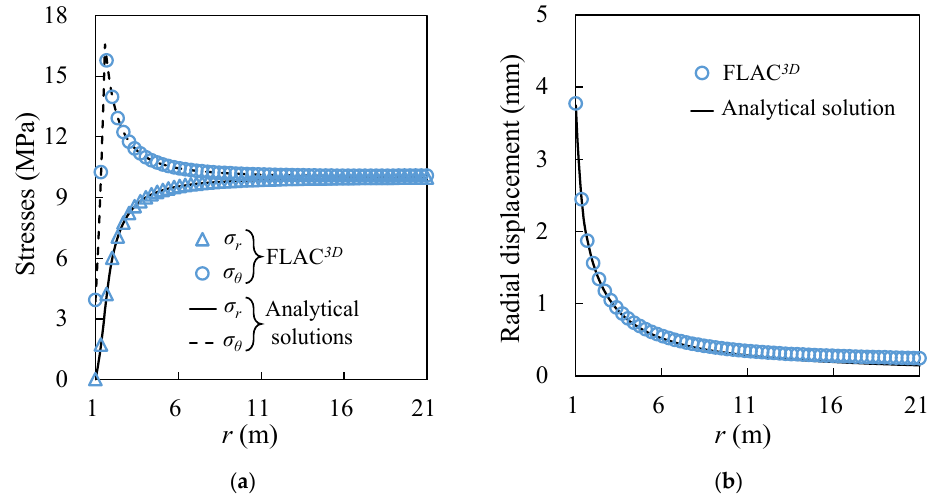
Figure A10. Comparisons between the numerical results and the analytical results of (a) σ r and σ θ , (b) U along x ‐ axis around a cylinder hole in the MC material.